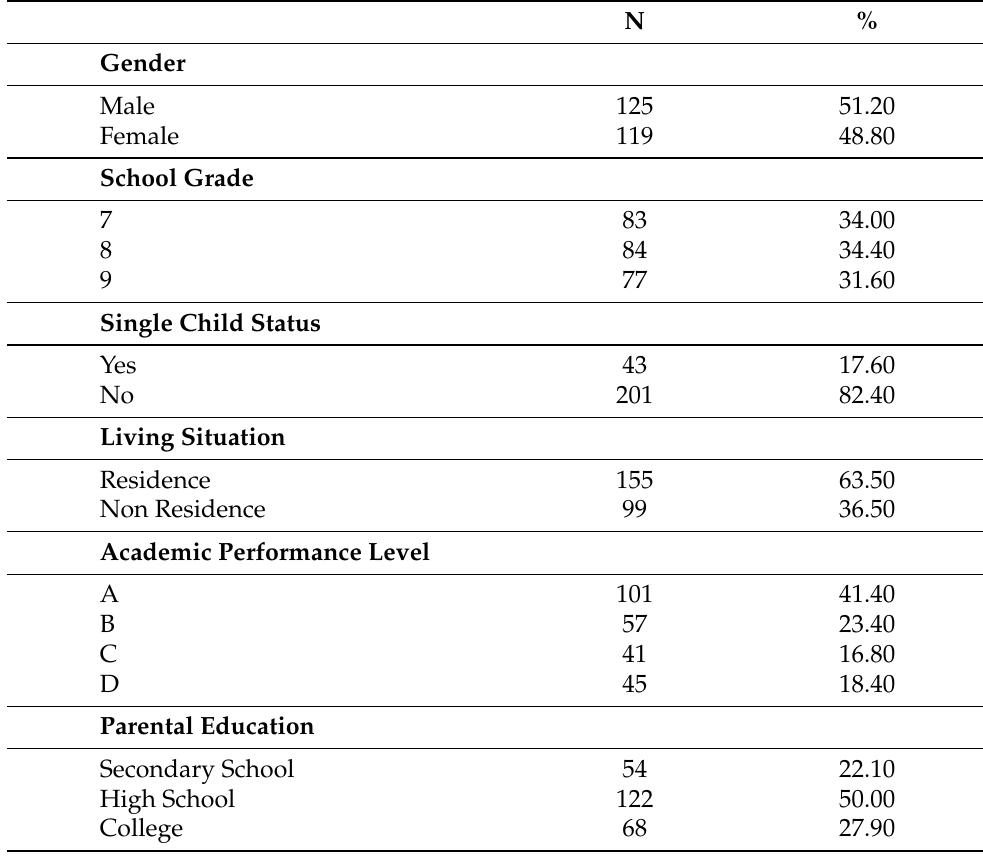
Table 1. Prevalence of main demographic variables in the